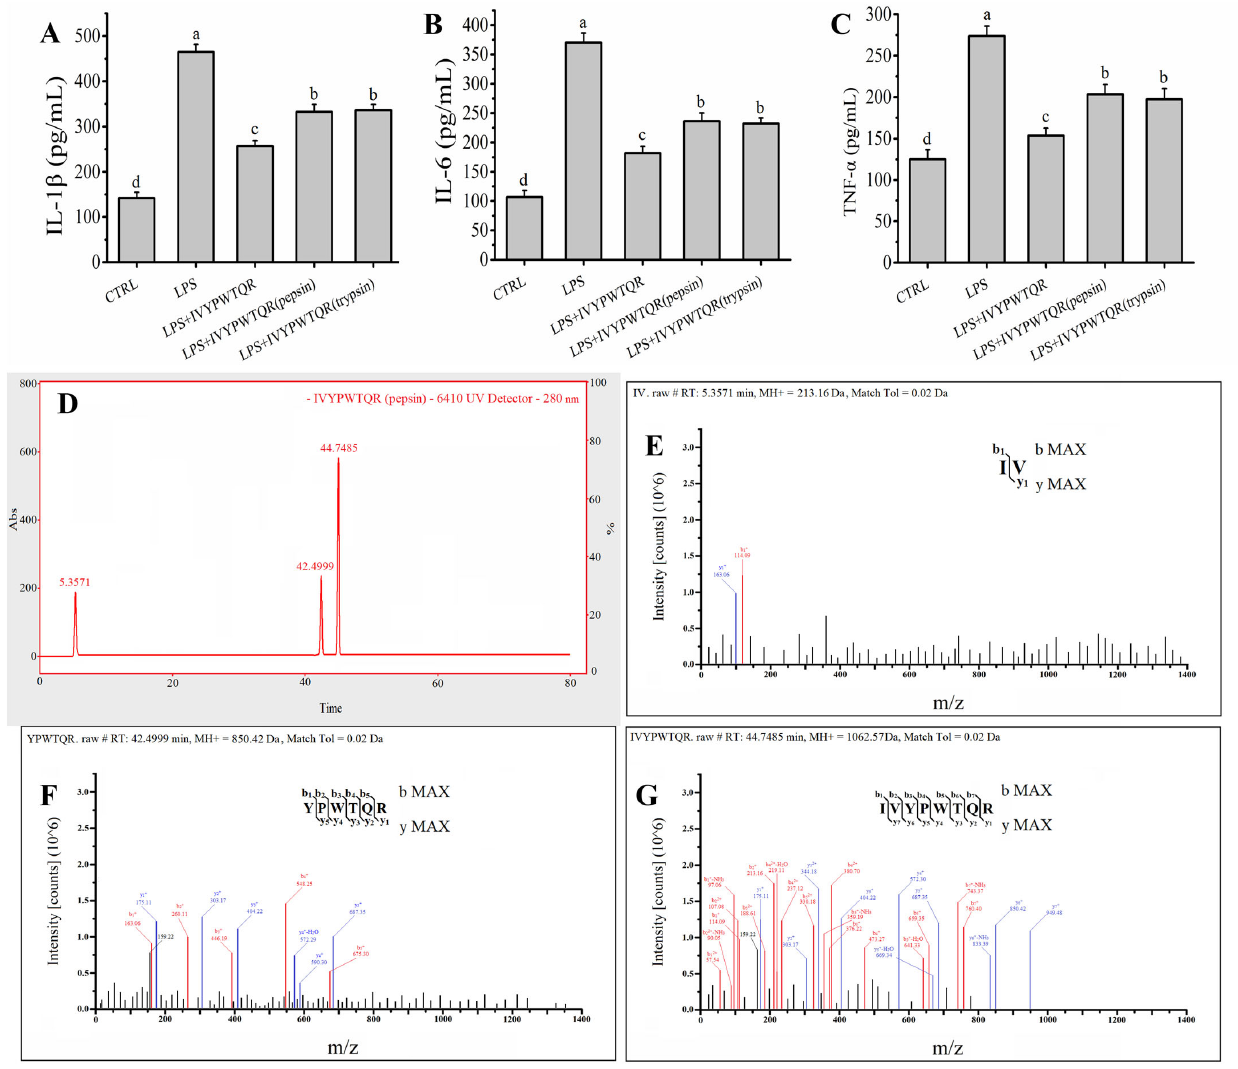
Figure 6. ( A – C ) Effects of the IVYPWTQR pre-treatment with pepsin–trypsin-simulated gastrointestinal digestion on the levels of IL − 1 β , IL − 6 and TNF- α on model of LPS-mediated RAW264.7 macrophages damage; ( D ) The total particles of RP-LC of IVYPWTQR pre-treatment with trypsin– simulated intestinal digestion; ( E – G ) Identification of the molecular weight and amino acid sequence of peak at 5.3571 min, 42.4999 min and 44.7485 min by MS/MS spectrum; Different letters (a, b, c, d) in figures indicate significant differences ( p < 0.05).